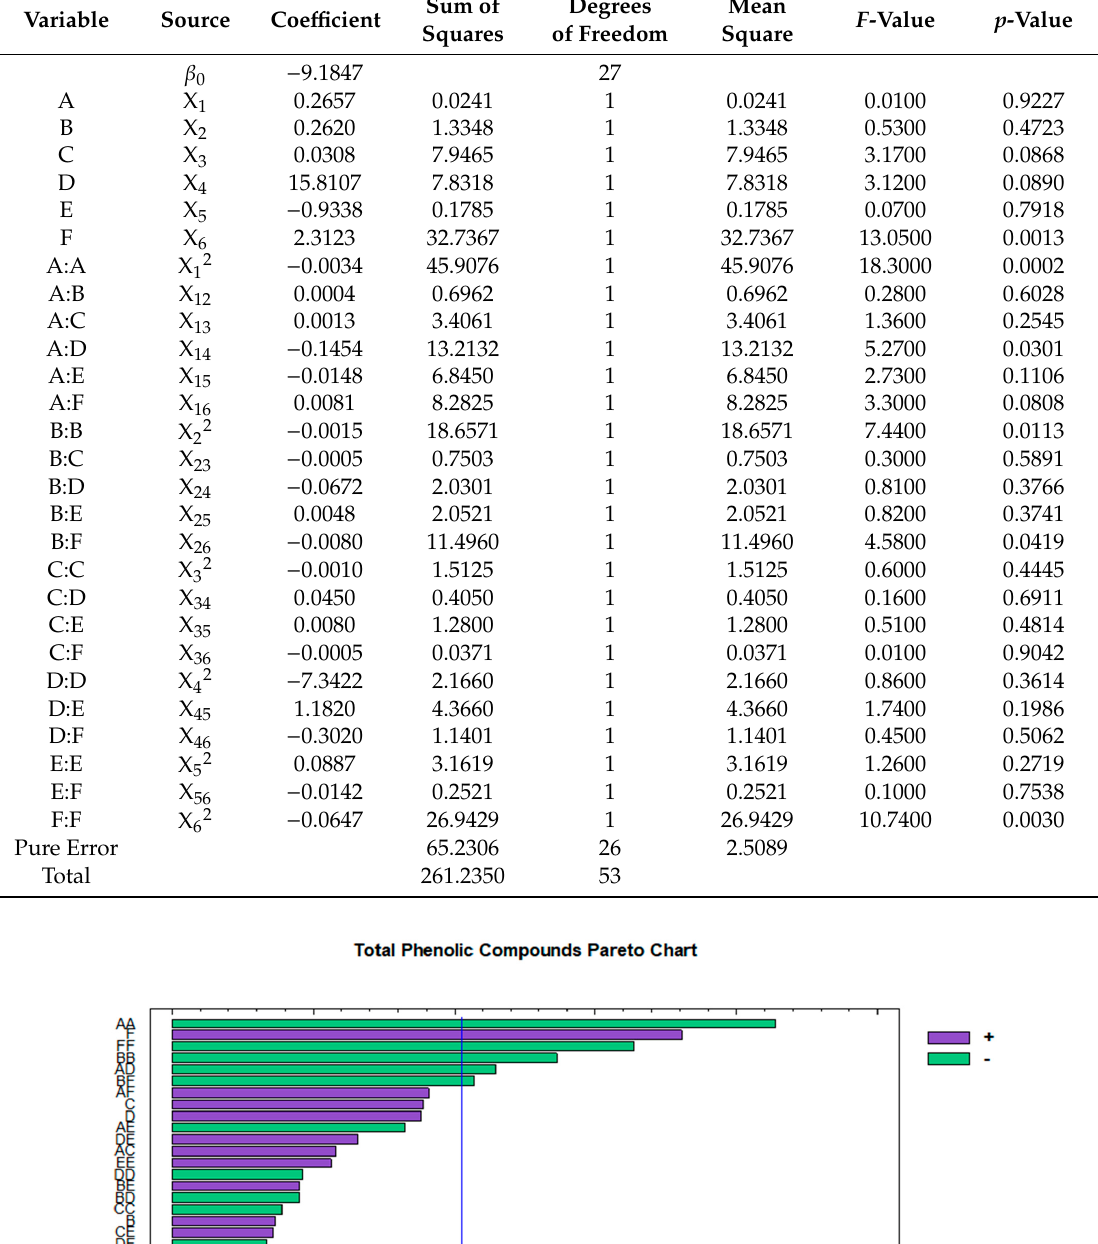
Table 5. Analysis of variance of the quadratic model adjusted to the extraction of total phenolic compounds. A: %MeOH; B: temperature; C: amplitude; D: cycle; E: pH; F: ratio.